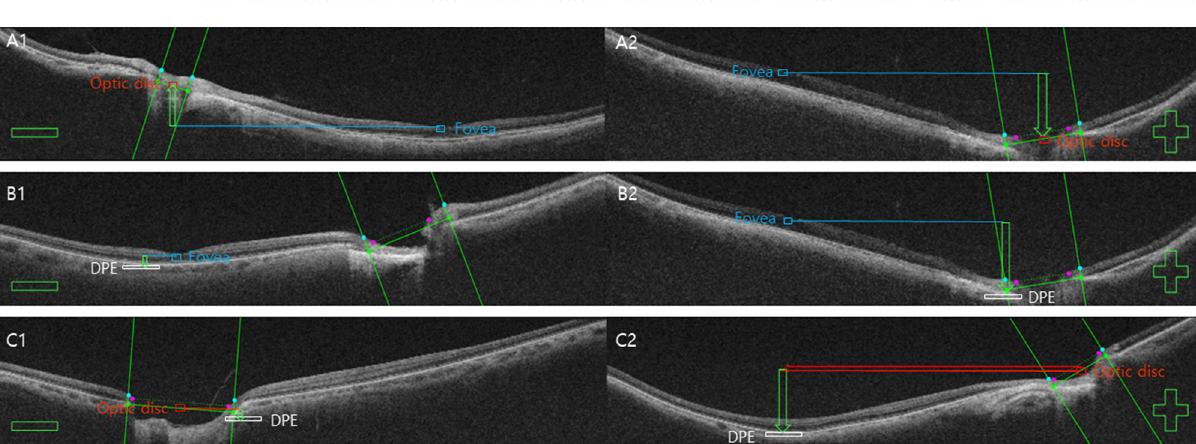
Figure 4. The concept of using relative anteroposterior elevation of the posterior globe between the fovea (blue square), the DPE (white square), and the optic disc (red square). The tomographic elevation from the fovea to the optic disc center (disc) was designated TEPS fovea → disc ( A ); from the fovea to the DPE, TEPS fovea → DPE ( B ); from the disc to the DPE, TEPS disc → DPE ( C ); and perpendicular distance from the disc to the DPE, TEPS distance (red arrow in ( C2 )). The tomographic elevation was estimated as the number of coronal sections between key indicators, with adjacent sections separated by 2.6 μm. The direction to the posterior (optic disc side) was specified as a positive tomographic elevation ( A2 , B2 , C2 ). The direction opposite from the anterior (corneal side) was designated as the negative tomographic elevation ( A1 , B1 , C1